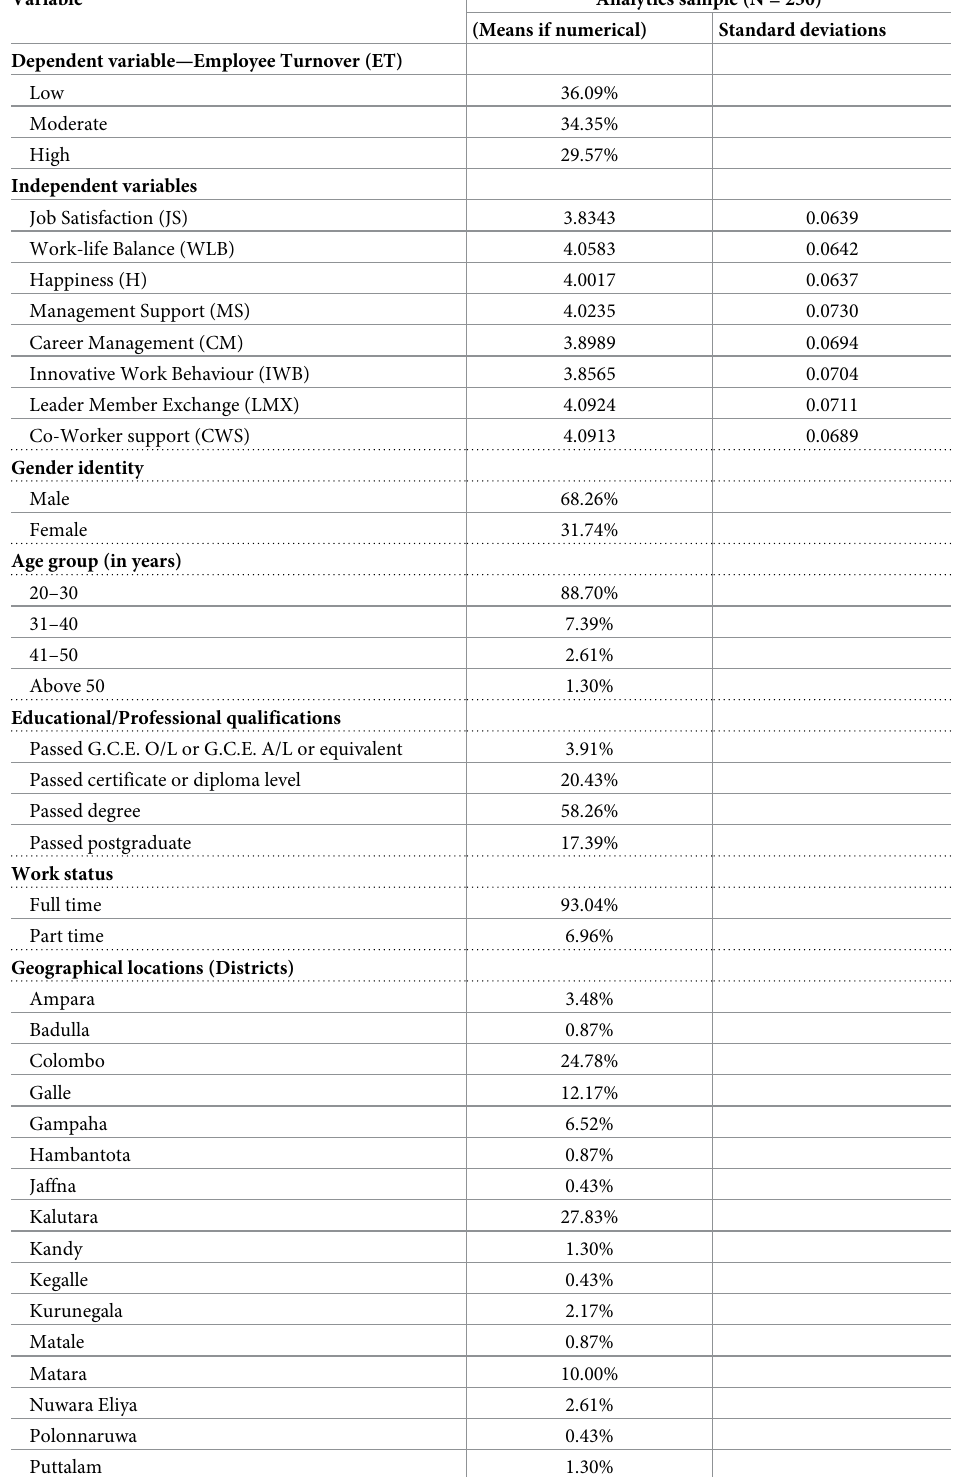
Table 1. Characteristics of employee turnover in Sri Lankan